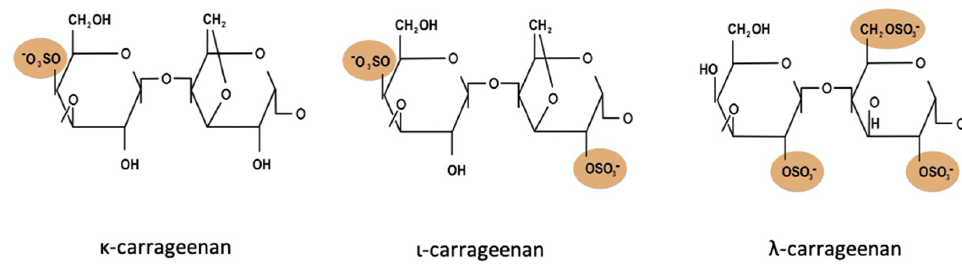
Figure 1. κ - ι - and λ -carrageenan primary structure.